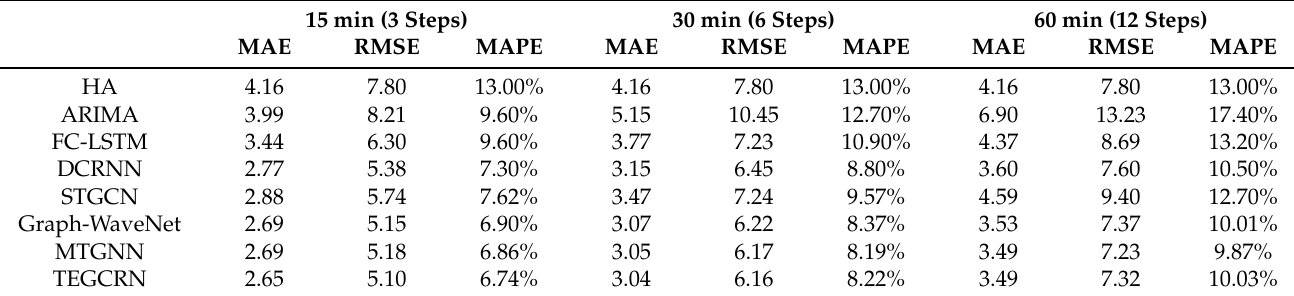
Table 3. Prediction Results of METR-LA Dataset.